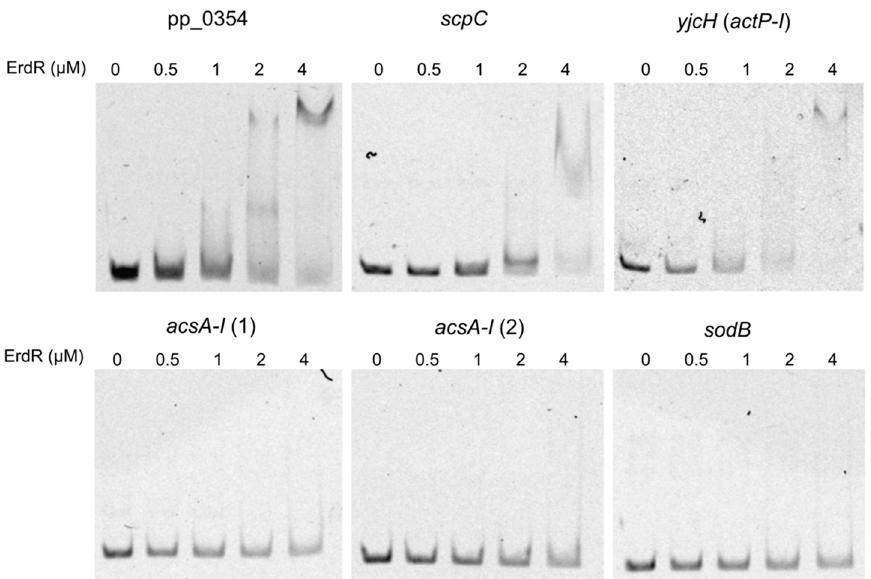
Figure 5. Comparison of binding of purified ErdR to promoter regions of given genes. The EMSAs were performed using different concentrations of ErdR (0, 0.5, 1, 2, and 4 µ M) and 2.5 ng of the amplified promoter regions (140 bp upstream of the start codon) of pp_0354, scpC , yjcH ( actP-I ) and acsA-I (1). An additional part of the promoter region of acsA-I (from nucleotide position 122 to 261 upstream of the ATG) was also tested ( acsA-I (2)). As negative control, an internal sequence of the sodB gene was used.